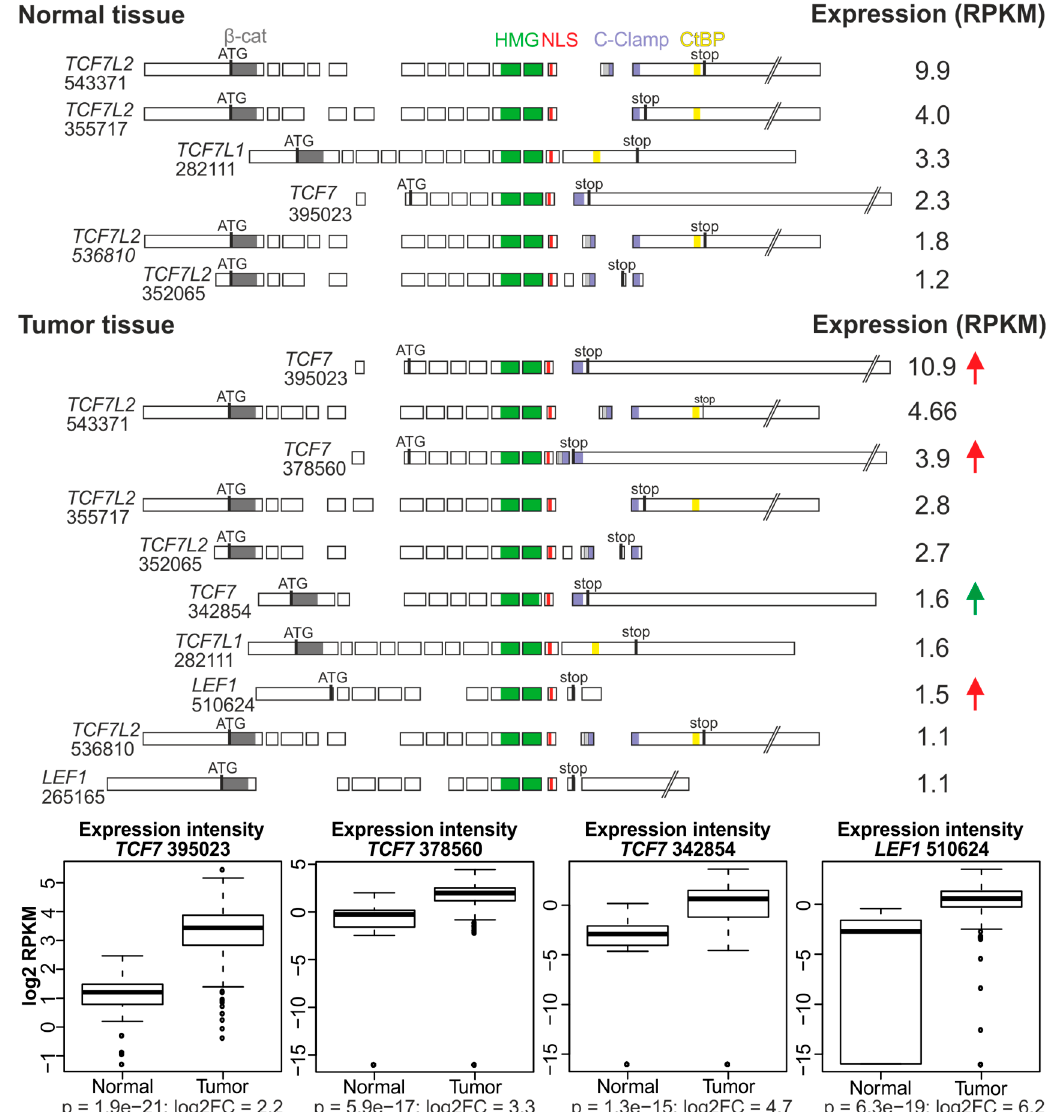
Figure 6. Expression of TCF/LEF isoforms in CRC specimens and normal colonic mucosa analyzed in the TCGA dataset. Upper schemes, a panel of the most abundant TCF/LEF transcripts produced in CRCs and in healthy human colon were sorted by expression intensity indicated as reads per kilobase per million mapped reads (RPKM) as inferred from the RNA-seq experiment; transcripts with RPKM >1 and annotated in the Ensembl genome version GRCh37 are shown. Each transcript is labeled by the last six-digit code from the corresponding Ensembl identificator. Transcripts that are expressed with significantly different abundance in tumor tissue (criterion: binary logarithm of fold change in the expression level (log2 FC) > 2 ( p < 0.001), nonparametric Mann-Whitney U test) are marked by red (dominant-negative forms) or green ( β -catenin-binding forms) arrow. Bottom diagrams, expression intensity box-and-whiskers plots for four TCF/LEF transcripts that are significantly more abundant in tumors compared to healthy colon tissue. The expression level of each selected transcript is statistically evaluated in all normal and tumor samples and represented by box plots. The expression level is given in log2 RPKM. Upper and lower borders of the box represent first and third quartiles, respectively. Median of expression is indicated by the bold line inside each box. The range of adjoining values (1.5 IQR) is shown by whiskers; outlying values are depicted as open circles; the corresponding p value and log2 FC for each transcript is shown at the bottom of each plot. The methodology is described in detail in Supplementary Materials.